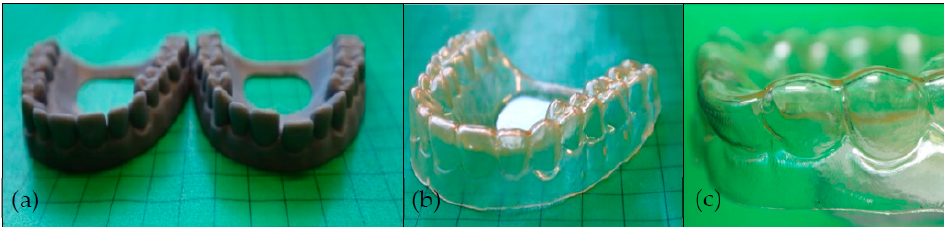
Figure 6. Digitally modeled and 3D-printed denture without malocclusion ( a , left) and with misa- ligned incisor ( a , right) and the corresponding aligner with targeted tooth position deep-drawn with SMP via thermoforming ( b ) and close-up of the programmed aligner with incisor malocclusion ( c ). Now, the aligner was placed on a model denture with a loose incisor at the same position, at which the model showed tooth misalignment (Figure 6a, right), and was heated to 80 °C. The thermo-responsiveness of the aligner is shown in the image series of Figure 7 and the corresponding Video S1 movie in the Supplementary Materials.